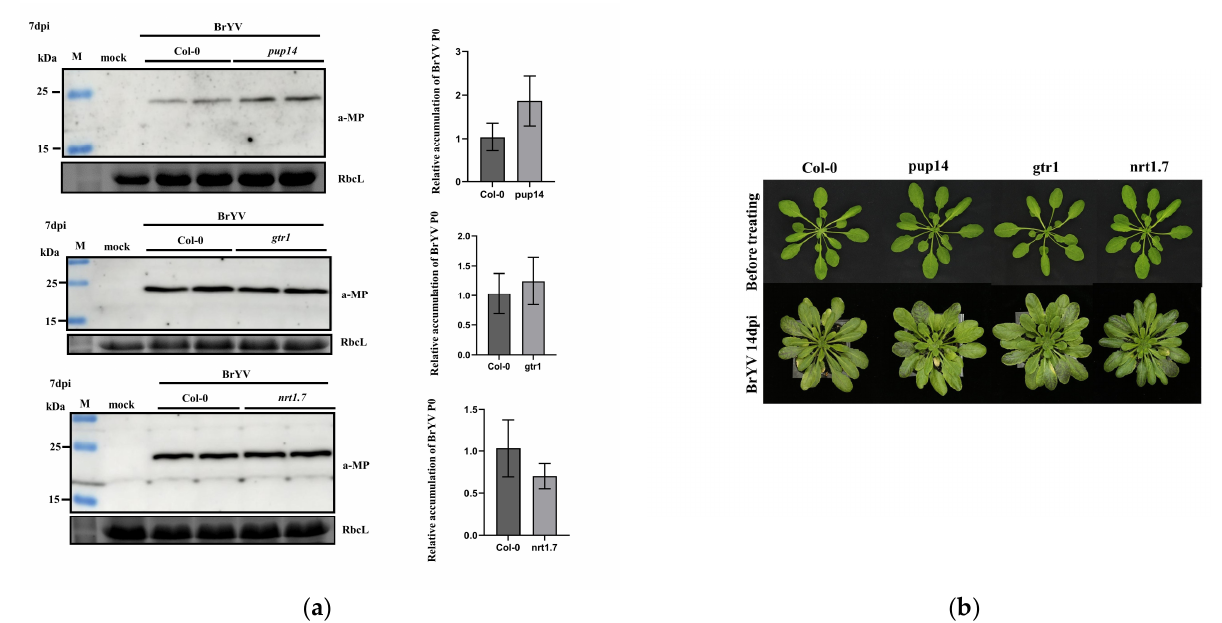
Figure 5. Effects of T-DNA insertion mutants of P3a-interacting proteins on BrYV accumulation. ( a ) Western blotting showing the accumulation of BrYV-MP in systemically infected leaves at 7 dpi. RbcL served as a loading control. qRT-PCR analyses of viral RNA accumulation; AtActin2 was used as an internal control; ( b ) Development and symptom induction of Col-0, pup14 , gtr1 , and nrt1.7 under normal conditions or BrYV infection at 14 dpi.